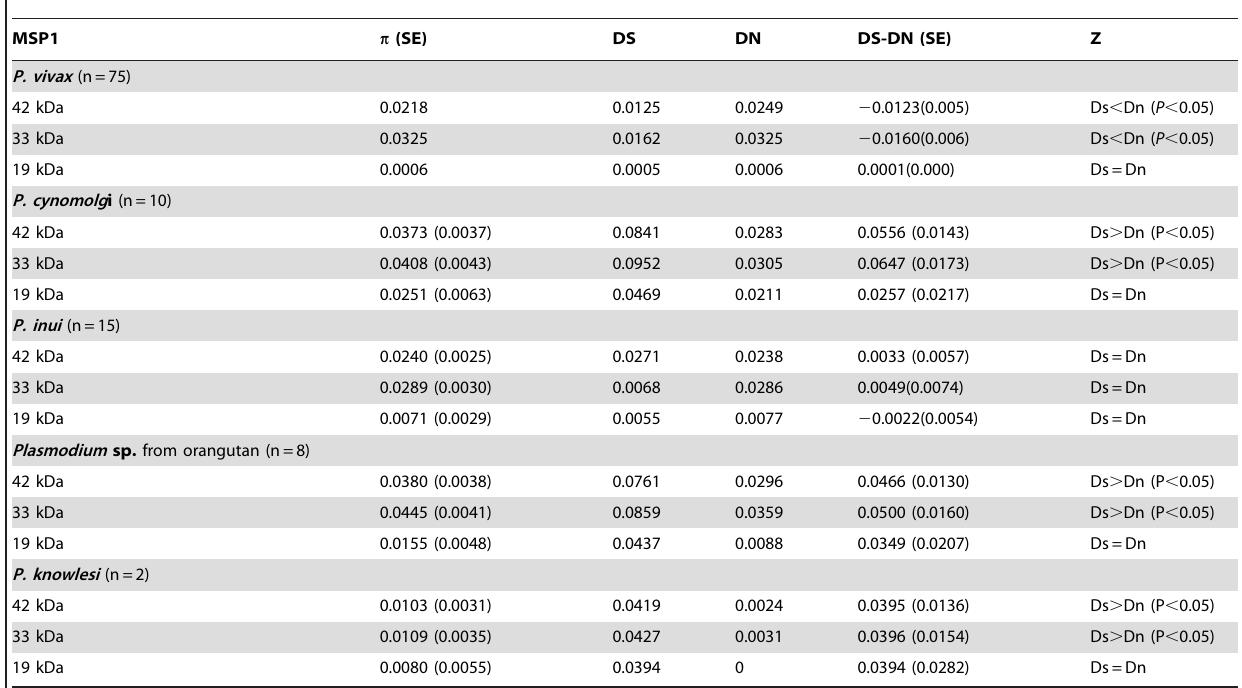
Table 2. Polymorphism found in the MSP1 42 gene in different Plasmodium species.